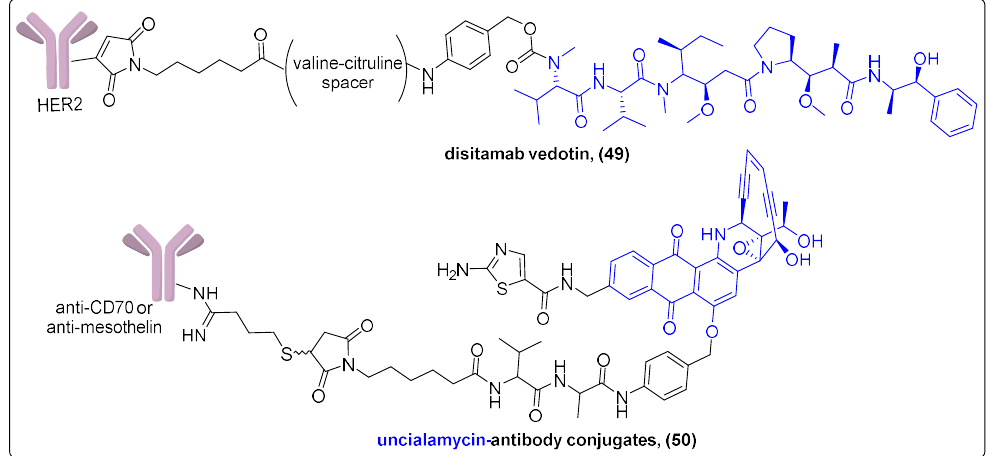
Figure 15. ADCs in preclinical and clinical studies.